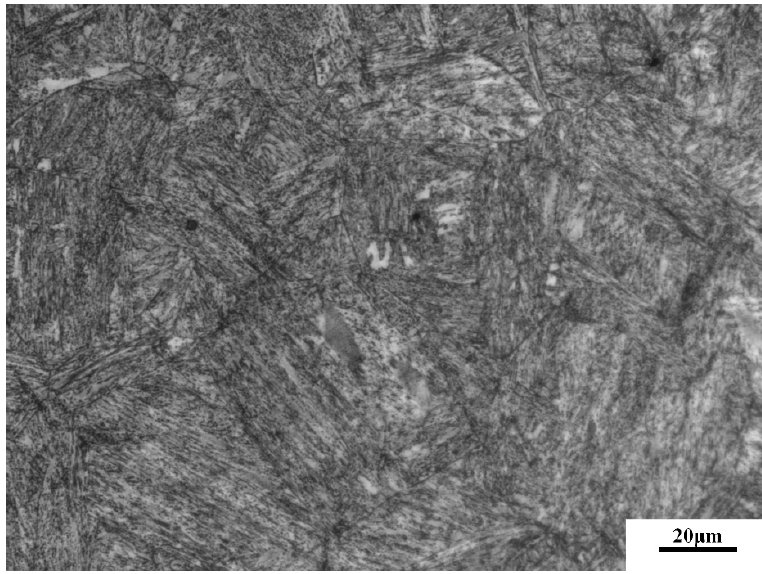
Figure 1. Microstructure of the KMN steel.